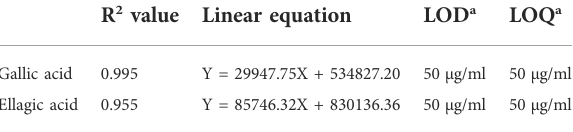
TABLE 2 Linearity and sensitivity of gallic acid and ellagic